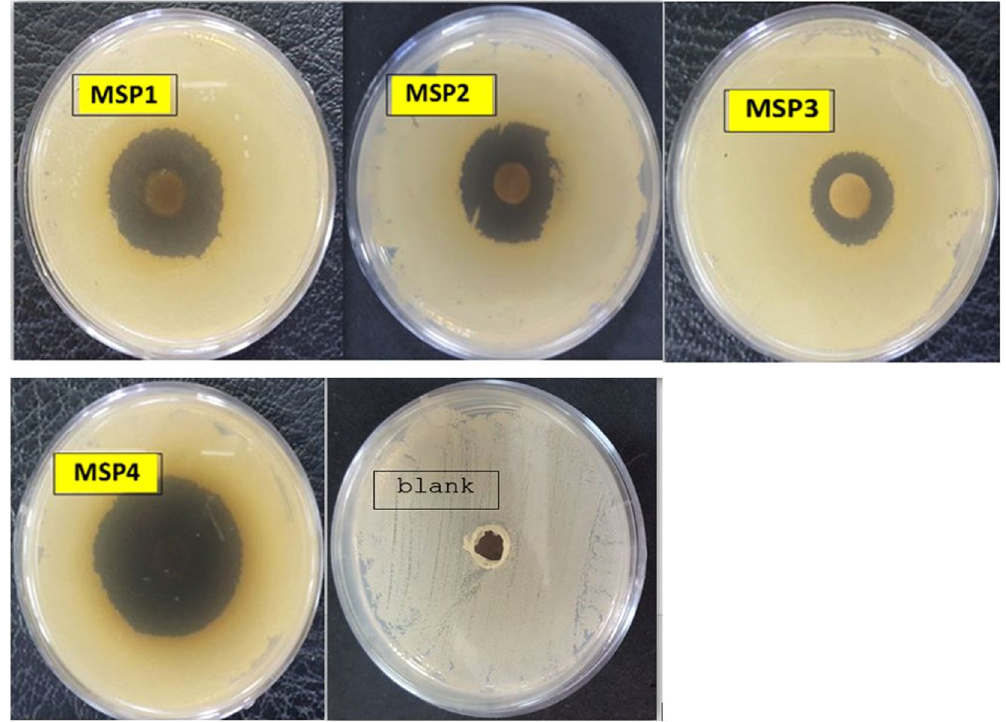
Figure 6. Inhibition zone diameters (mm) obtained of Staphylococcus aureus in disc diffusion test for MSP1–4 (5 mg) and